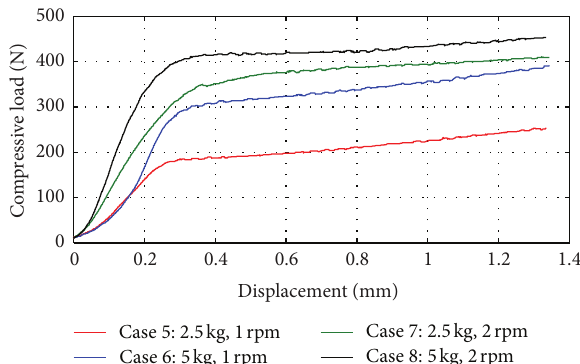
Figure 7: Load-displacement curve of NGH pellet (cases 5, 6, 7, and 8).